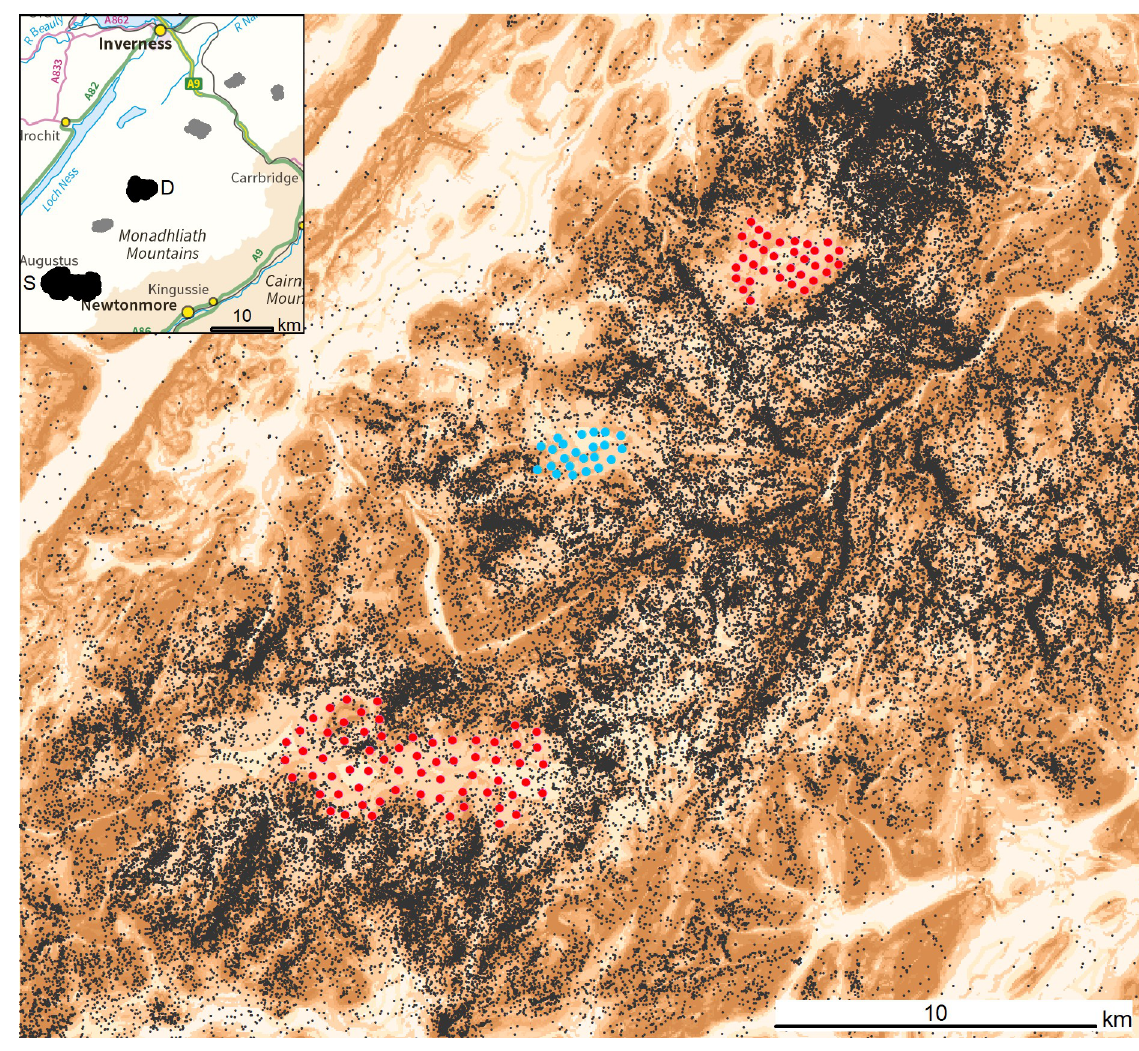
Fig 1. The location of Dunmaglass and Stronelairg wind farms in central Scotland (D and S in black, with other wind farms in dark grey: Internal box). Wider illustration shows the location of turbines (red circles) including the Corriegarth Wind Farm (blue circles), between Dunmaglass and Stronelairg, which was fully operational 30 September 2016. Black dots show non-territorial golden eagle GPS- telemetry records ( � 530,000) from after Stronelairg became operational in 2018 (see main text). The backdrop is a colour scale representation of eagle habitat preference according to the Golden Eagle Topography (GET) model [45], with darker tone indicating greater predicted preference. Contains Ordnance Survey data © Crown copyright and database right 2017.